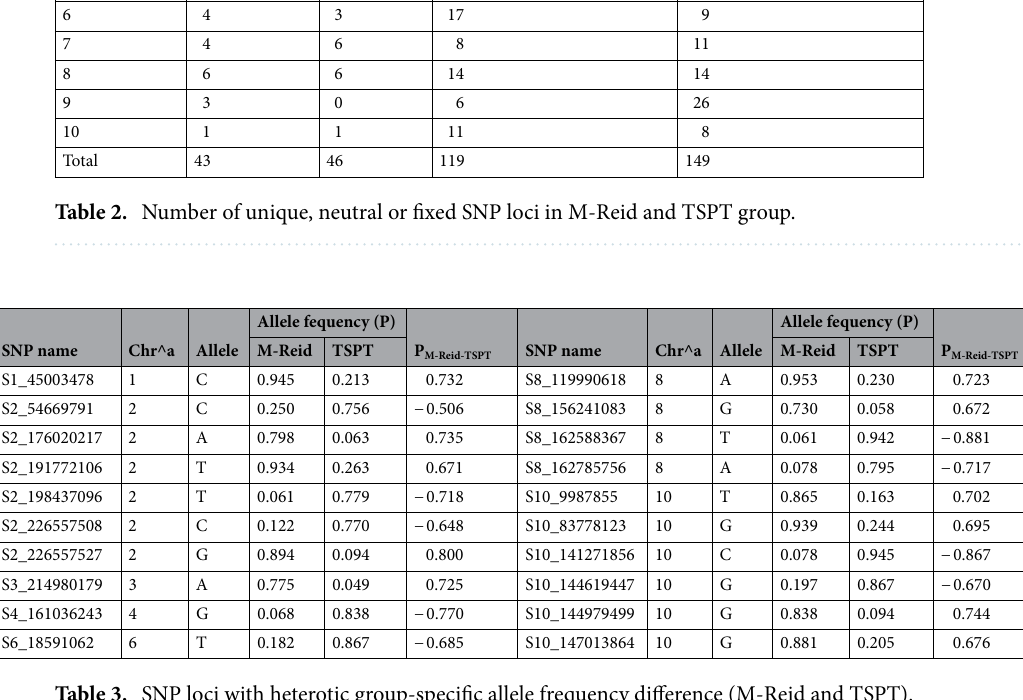
Table 3. SNP loci with heterotic group-specific allele frequency difference (M-Reid and